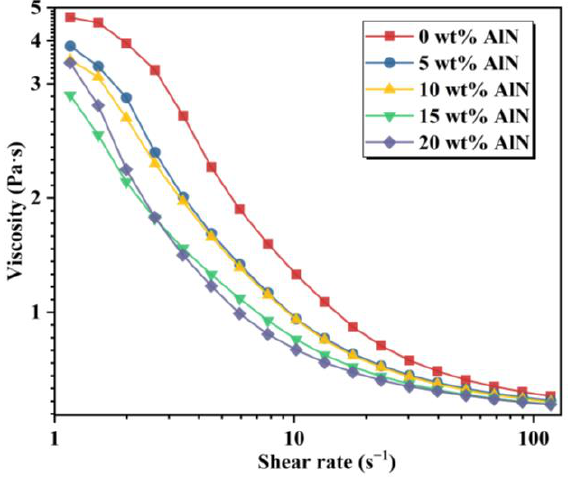
Figure 1. Viscosity versus shear rate curves of suspensions with different content of AlN powders. The stability of suspensions, which is always affected by the agglomeration and sedimentation of the ceramic powders, is an important factor to be considered. The diagram of the sedimentation test is exhibited in Figure 2a. The solid loading of suspensions was maintained at 10 vol%, and the amount of AlN varied from 0 to 20 wt%. The sedimentation